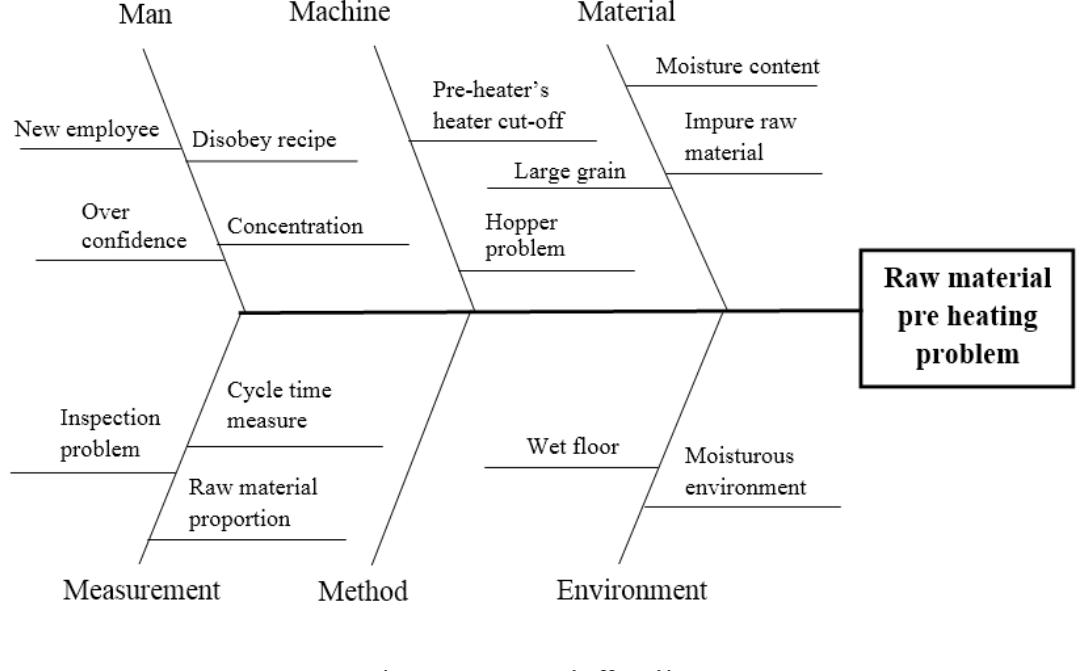
Figure 2. Cause and effect